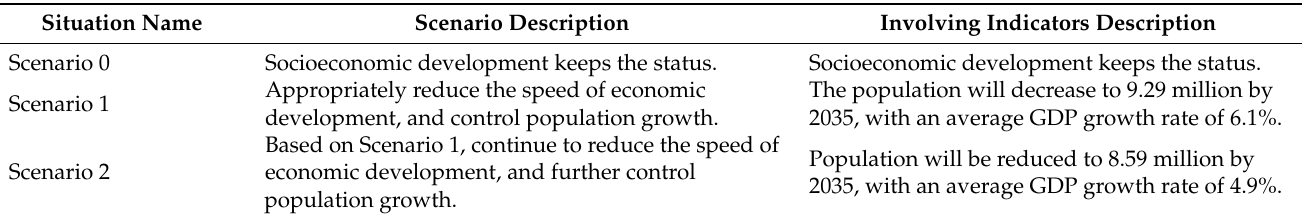
Table 2. Different Scenarios of the Green Space Composite System Developed for Beijing’s Central